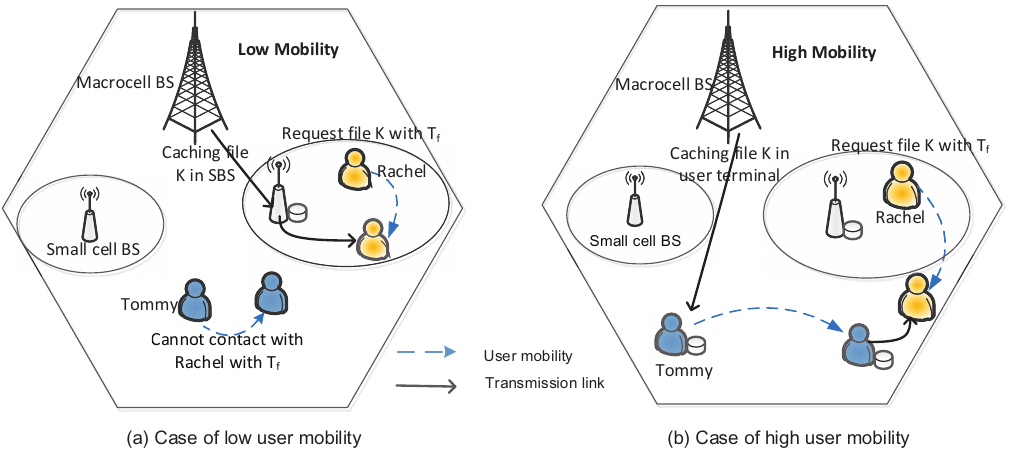
Figure 3. Illustration of the content caching placement. ( a ) Case of low user mobiliity; ( b ) Case of high user